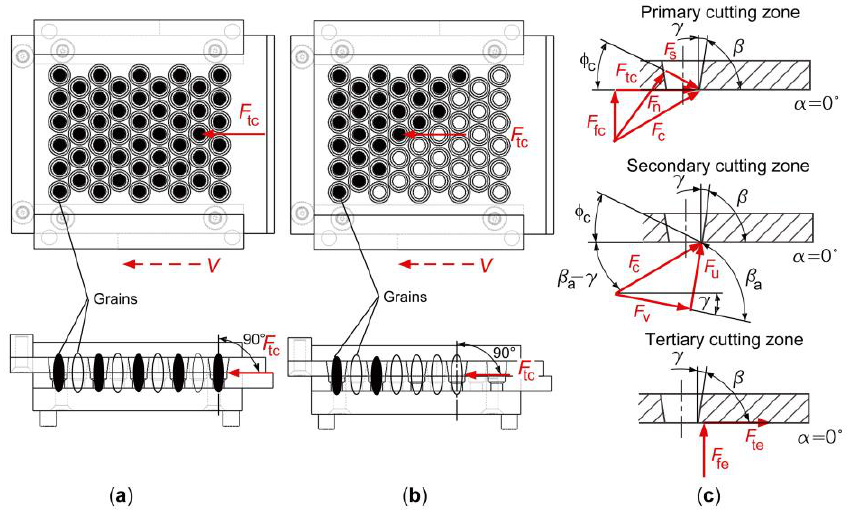
Figure 6. Force distribution in orthogonal cutting method: ( a ) rectangular grain formation; ( b ) right triangle grain formation; ( c ) components of cutting force.